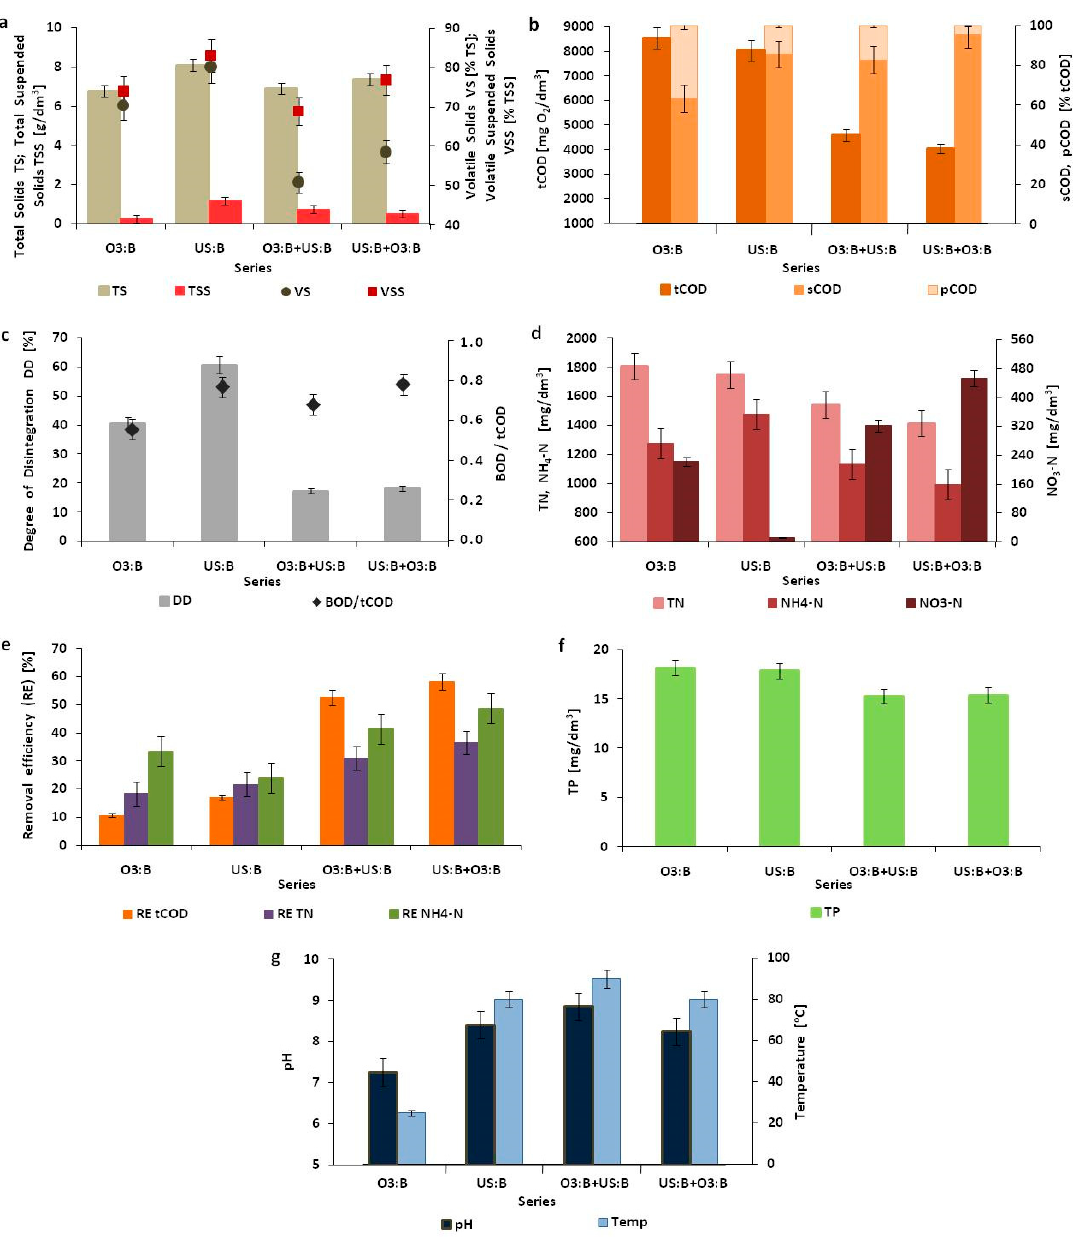
Figure 5. Effect of ozonation, ultrasonication and combination of these processes on the digestate liquid fraction composition: concentrations of TS, VS, TSS and VSS ( a ); tCOD concentration, percentage of sCOD and pCOD in tCOD ( b ); degree of disintegration and BOD/tCOD ratio ( c ); concentrations of TN, NH 4 –N and NO 3 –N ( d ); removal efficiency of tCOD, TN and NH 4 –N ( e ); TP concentration ( f ); pH and temperature ( g ).